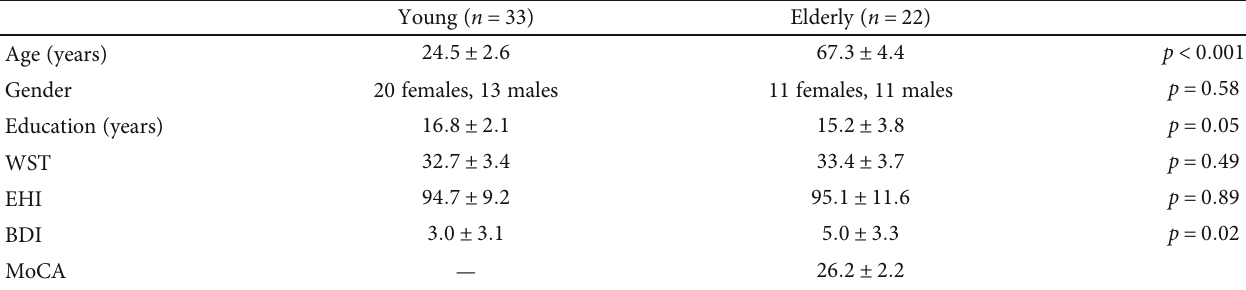
Table 1: Demographic characteristics of young and elderly participants ( mean ± SD